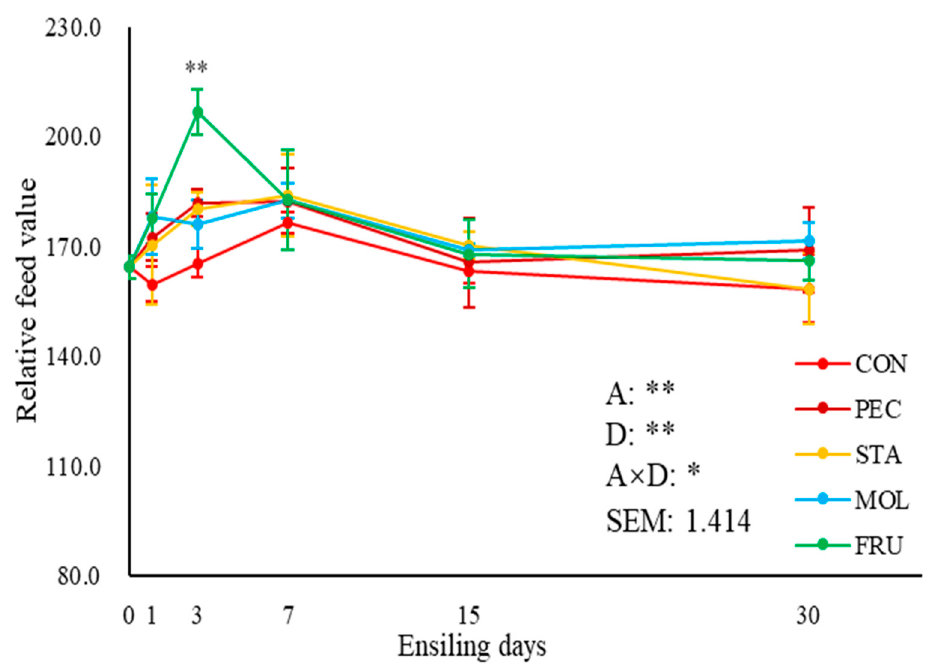
Figure 5. Effect of additives on the relative feed value (RFV) during ensiling of alfalfa. CON, control; PEC, pectin; STA, starch; MOL, molasses; FRU, fructose. A denotes significance of additives; D, denotes significance of ensiling days; A × D denotes the interactive effect between additives and ensiling days. SEM, standard error of means. The asterisks (* p ≤ 0.05; ** p ≤ 0.01) indicate the significance of additives and ensiling days and their interaction effects, and the difference at the specified ensiling day.